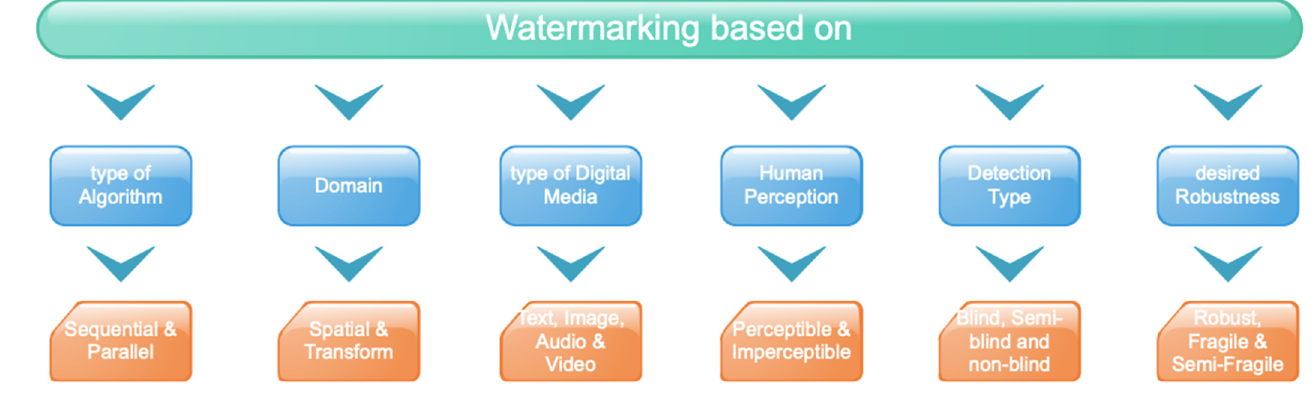
Figure 4. Classification of watermarking techniques [16].